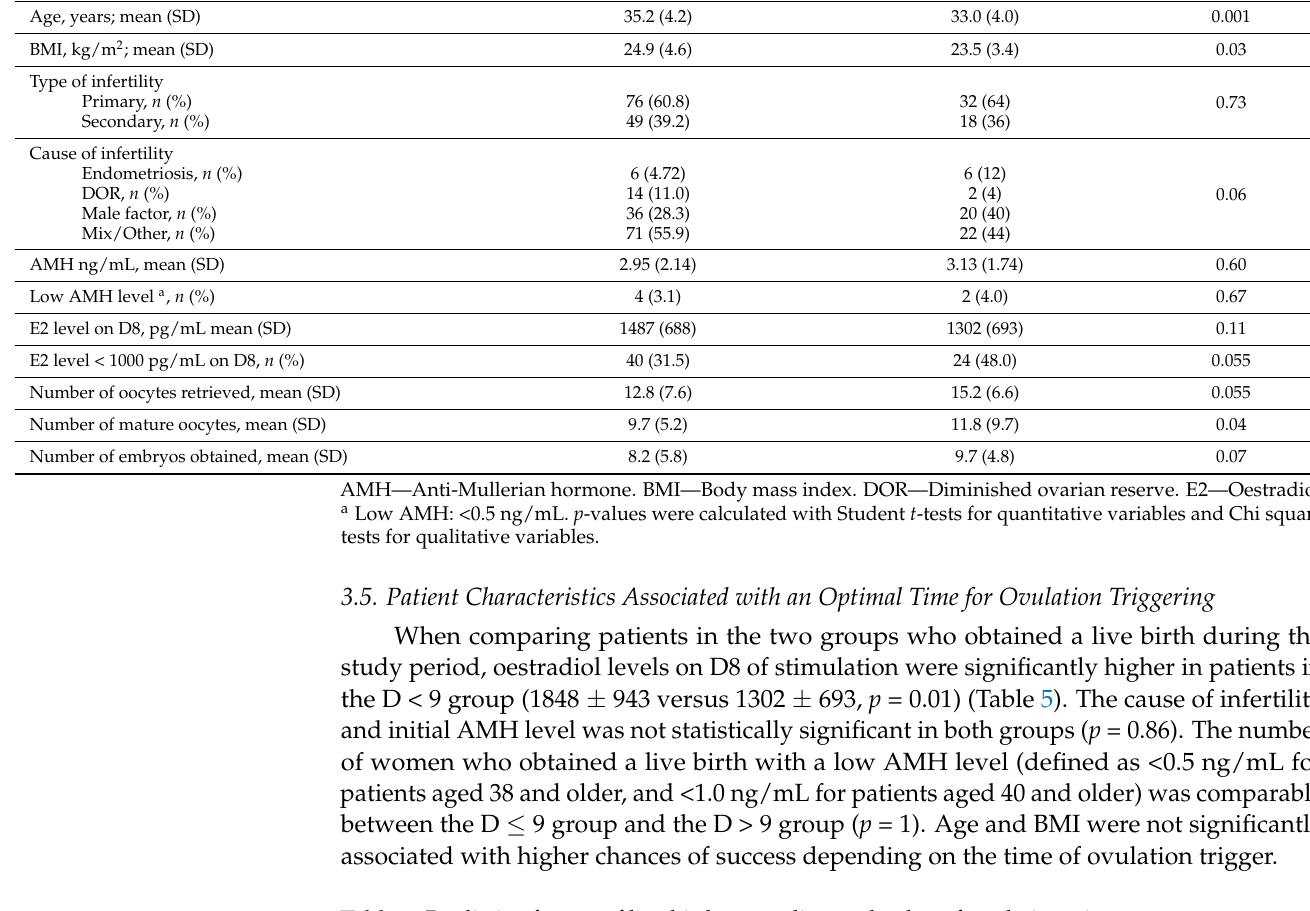
Table 5. Predictive factors of live births according to the day of ovulation trigger. D ≤ 9 Group with Live Birth n =